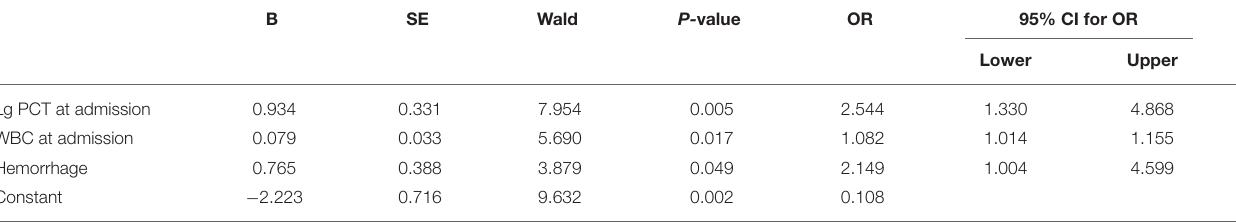
TABLE 2 | Independent risk factors for the severity of HFRS. B SE Wald P- value OR 95% CI for OR